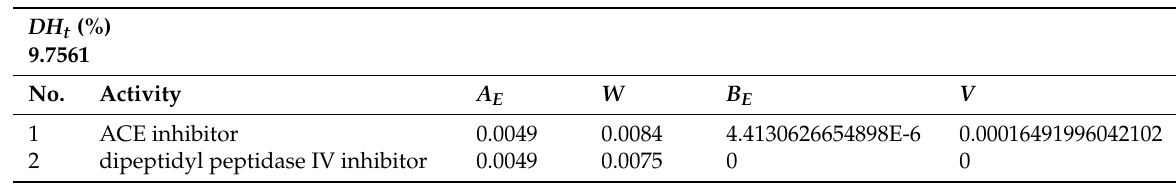
Table A44. A E , DH t , W , B E and V values from RubisCO of Halophila stipulacea . In silico enzymatic cleavage was carried out by using glycyl